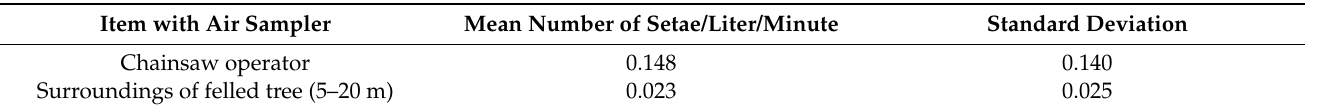
Table 2. Number of urticating setae per minute found in the samples taken with air pumps during the tree-felling